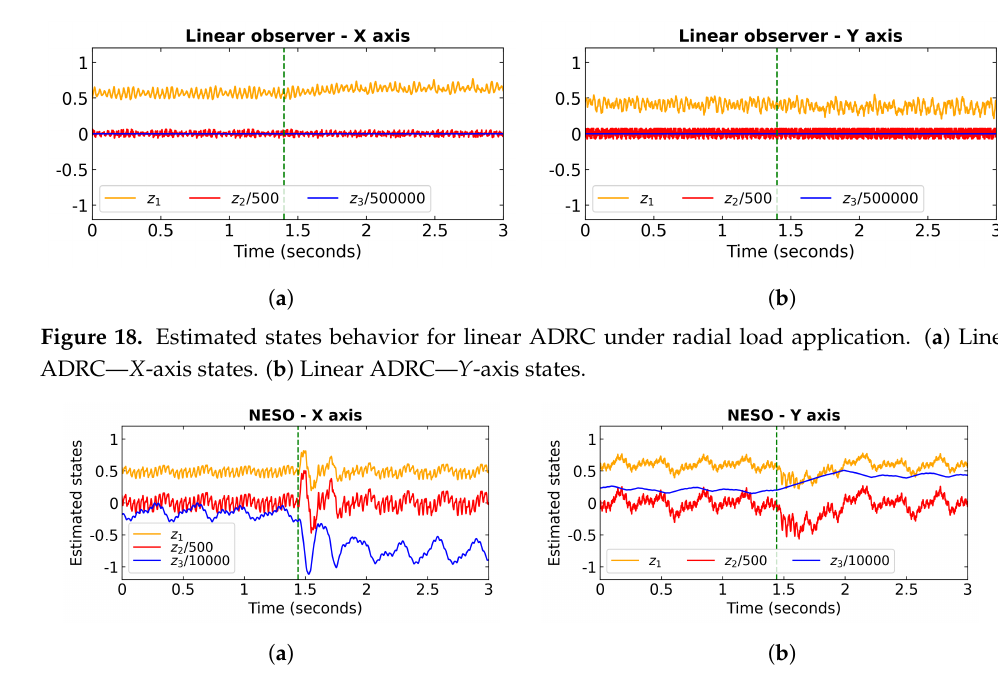
Figure 19. Estimated states behavior for nonlinear ADRC under radial load application. ( a ) Nonlinear ADRC— X -axis states. ( b ) Nonlinear ADRC— Y -axis states.